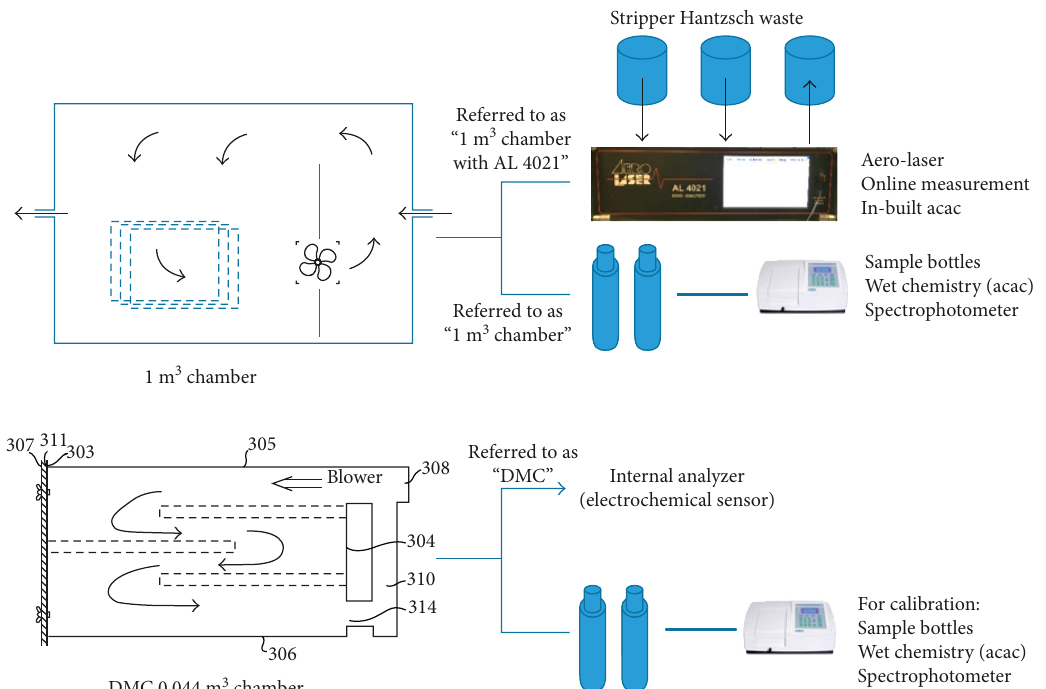
Figure 1: Air flow inside the 1m 3 chamber and the dynamic microchamber (DMC) [31], the different measurement pathways, and how they are referred to in this article.